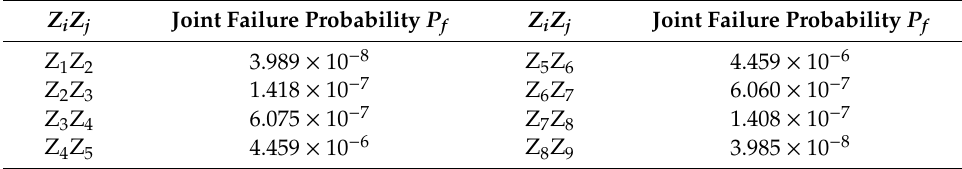
Table 10. The joint failure probability of each pair of failure modes based on a Gaussian